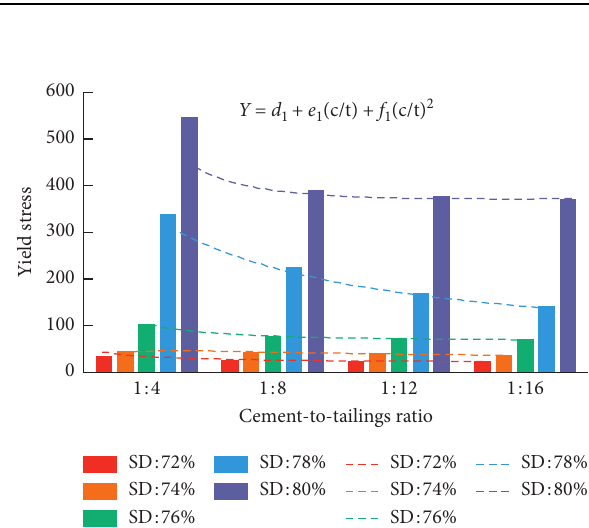
Figure 4: Histogram between c/t and yield stress of CUTB samples.